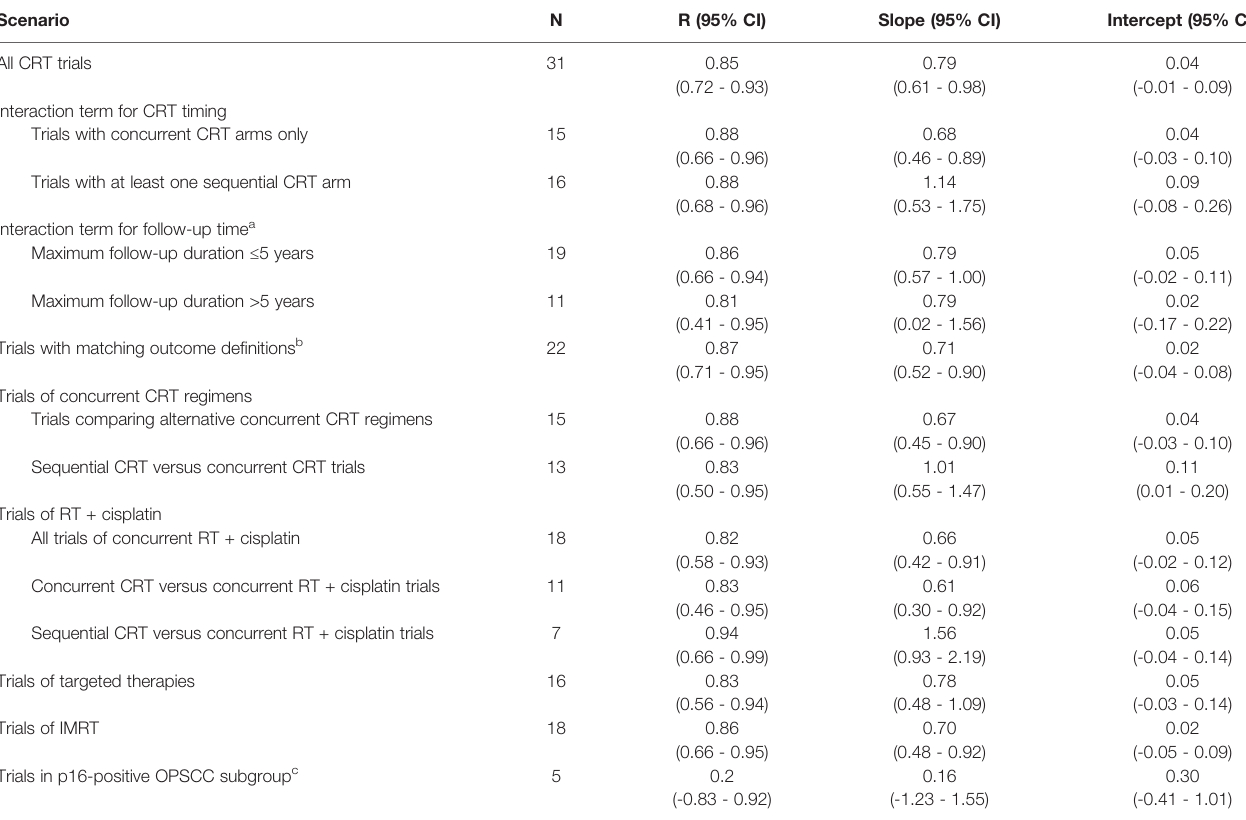
TABLE 1 | Estimated correlations between EFS and